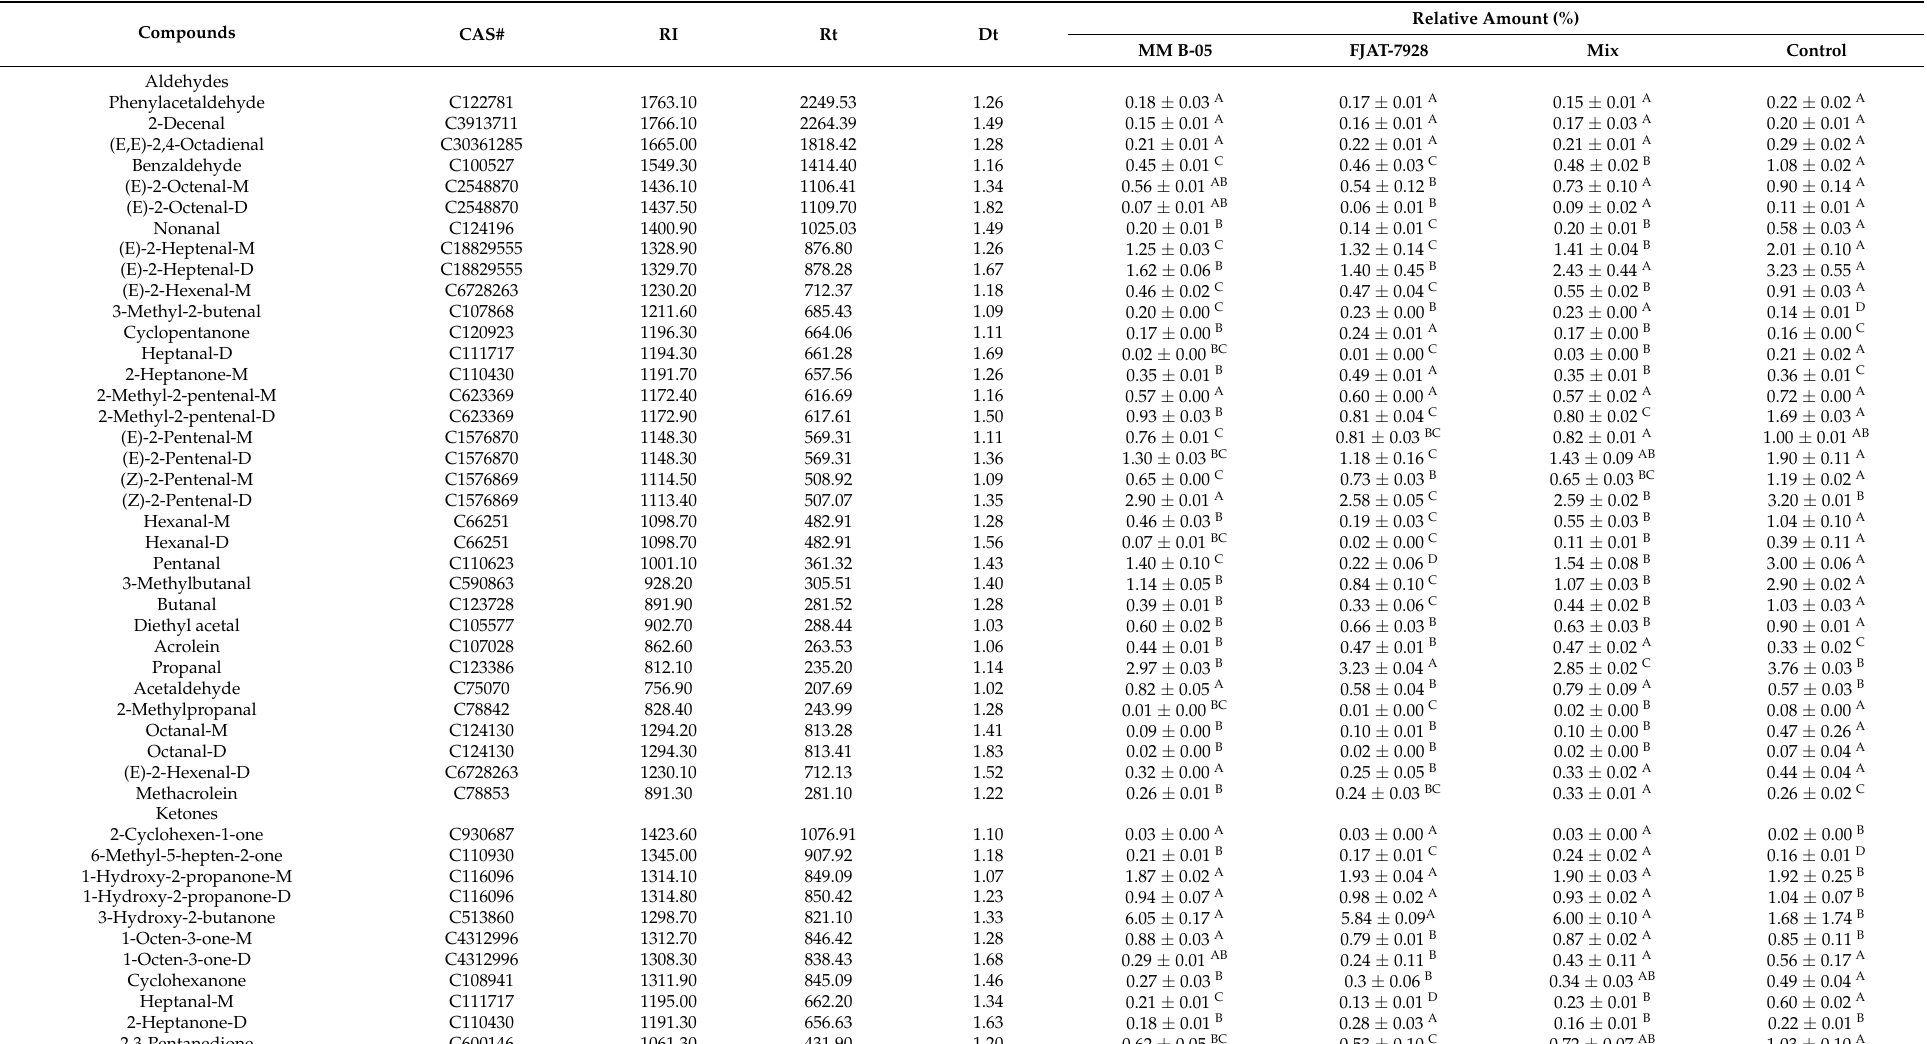
Table 4. The relative content of volatile flavor compounds of P. yezoensis sauce after fermentation (72 h).